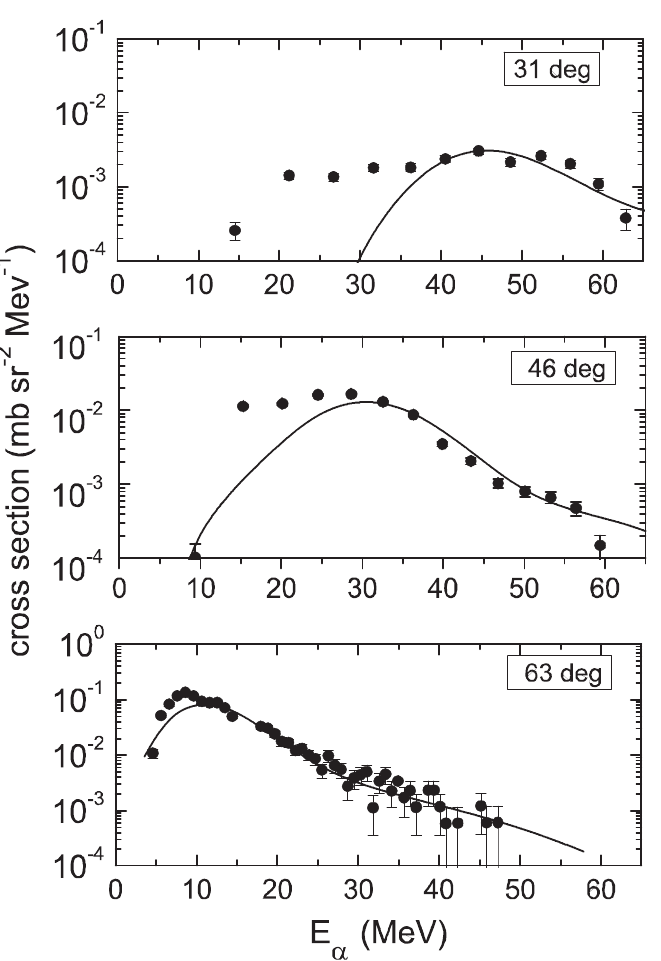
Fig. 3. Energy sharing cross section distribution for the 12 C(p, αp) 8 Be knockout reaction at quasifree angles extracted from the study of Mabiala et al. [11] at an incident energy of 100 MeV. Results are shown as a function of α-particle kinetic energy. Angles of observation of α-particles are indicated. The curves represent results of DWIA predictions for a pure knockout